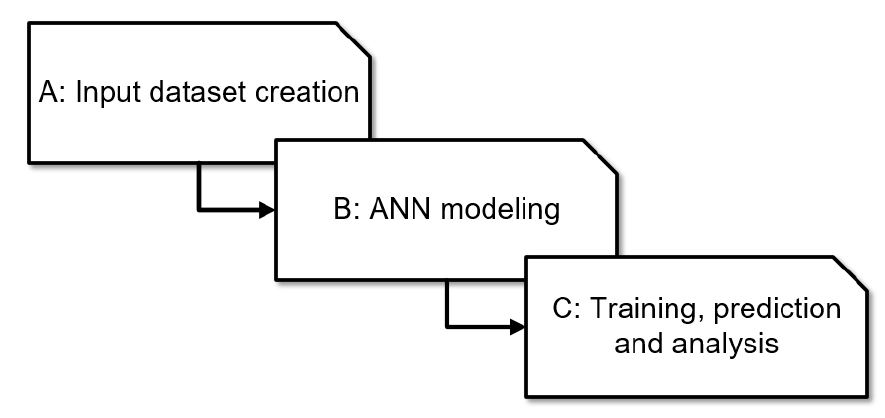
Figure 1. Overview of the methodology.